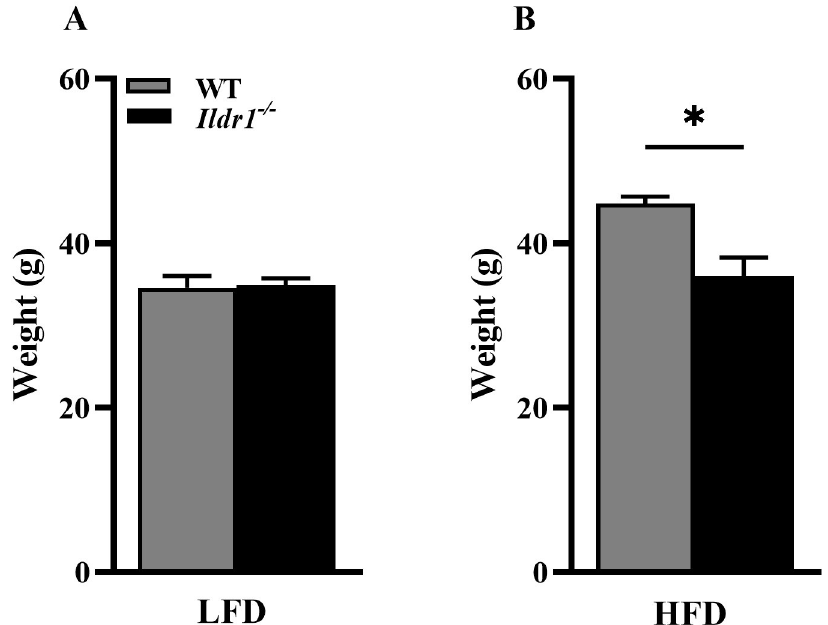
Fig 3. Body weights of wild-type (WT, grey bar) and Ildr1 -/- (black bar) mice fed a low (LFD) or high (HFD) fat diet. Mice were fed the low fat or the high fat diet for 18 days after removal from the CLAMS apparatus (total of 23 days). (A) Body weight of mice fed the LFD. (B) Body weight of mice fed the HFD [t(6) = 3.697, P = 0.010]. n = 4 mice/ genotype/diet; � P < 0.05, WT vs. Ildr1 -/- .